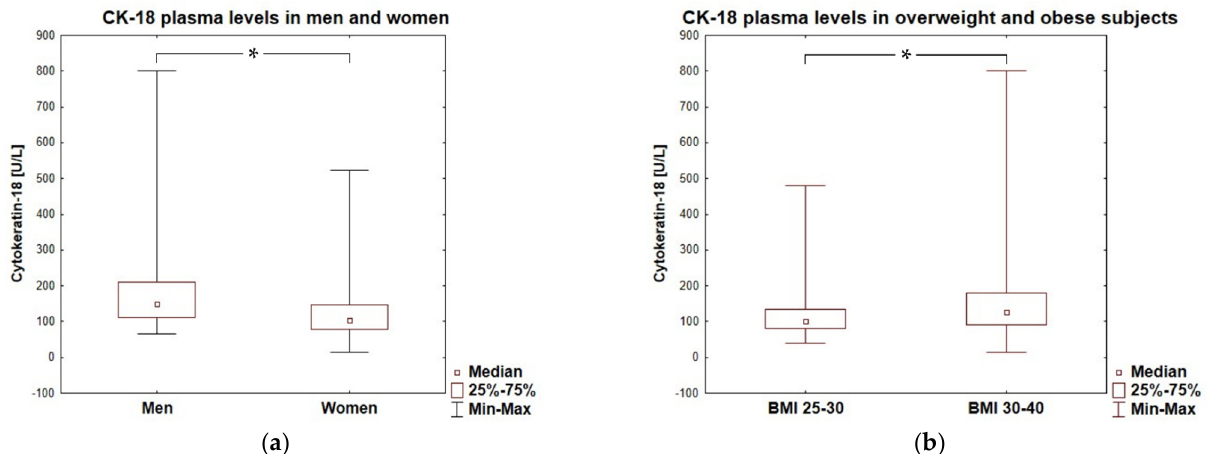
Figure 3. Cytokeratin-18 plasma levels in men and women ( a ) and in overweight and obese subjects ( b ). * represent a significant difference ( p < 0.05).